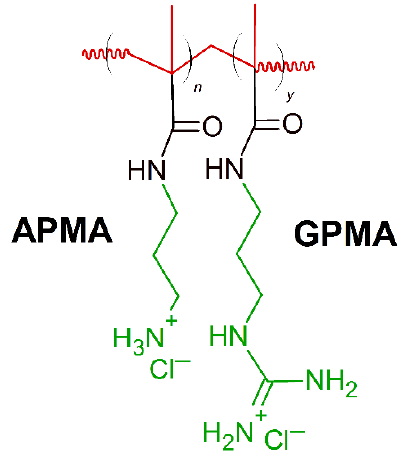
Figure 7. Schematic representation of aminopropyl methacrylamide (APMA)-stat-guanadinopropyl